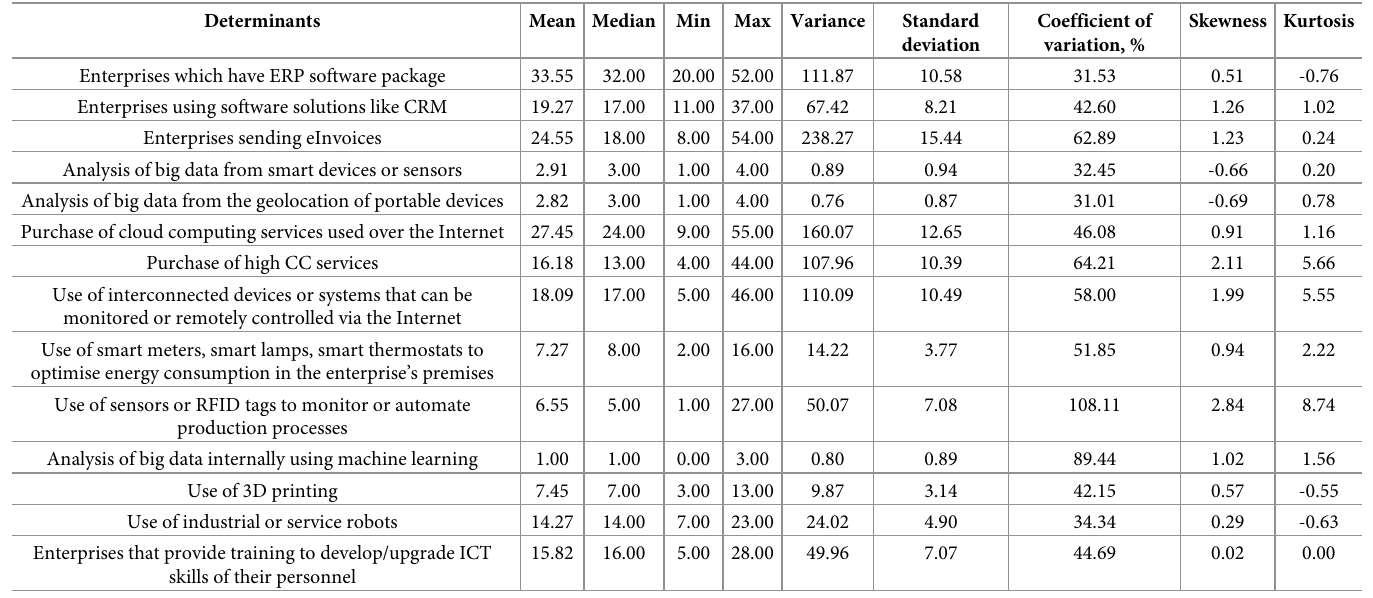
Table 8. Selected statistical parameters of the indicators determining the level of digital maturity among manufacturing enterprises in the CEE countries.